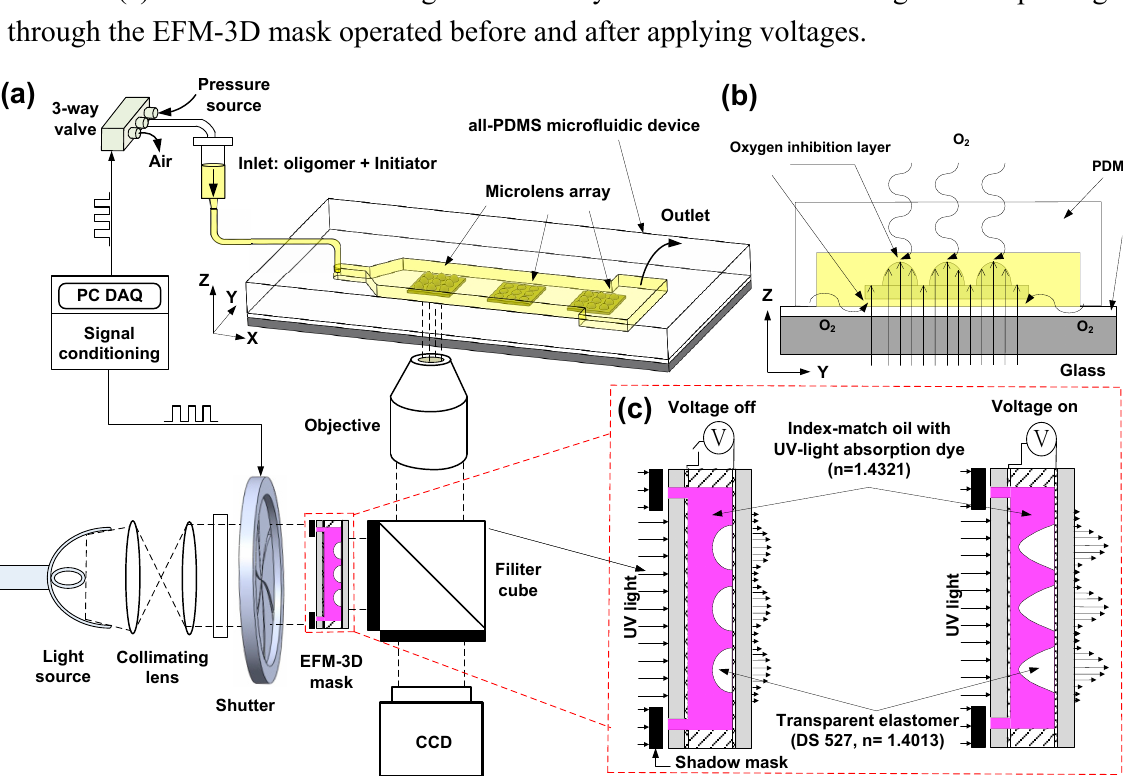
Figure 1. ( a ) Schematic illustrating the design concept for the continuous, high-throughput fabrication of microlens structures in microchannels. An adjustable electrostatic-force-modulated (EFM-3D) mask is inserted in the field-stop plane of the microscope. The acrylate oligomer stream flows through the polydimethysiloxane (PDMS) microfluidic device. The microlens structures are polymerized by a UV light transmitted through the electrostatic-force-modulated 3D (EFM-3D) mask and the microscope objective, and then flow downstream without adhesion on the PDMS surfaces. ( b ) The side-view shows the photopolymerized microlens structures, the intensity distribution after passing through the EFM-3D mask, and the unpolymerized oxygen-aided inhibition